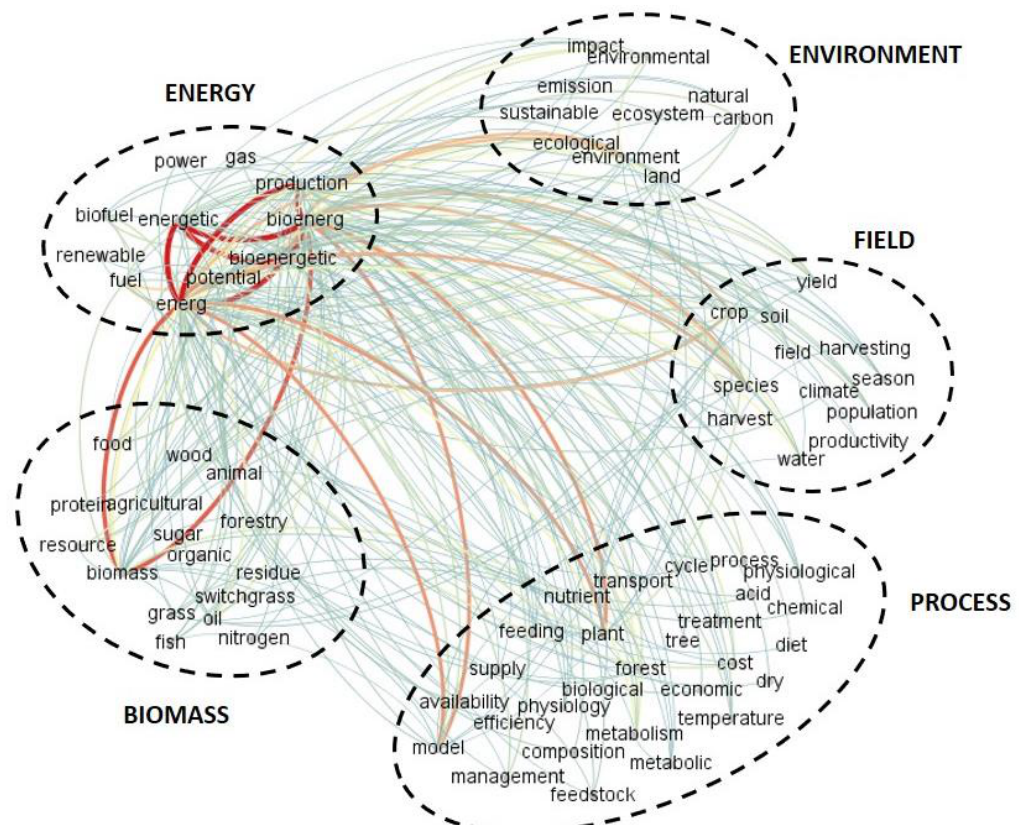
Figure 6. Interrelations between terms in the title, keywords, and abstract sections. Thicker and darker colored lines indicate a more significant number of connections. The circles indicate different clusters. For better visualization, only terms with at least 700 co-occurrences with at least one other term are